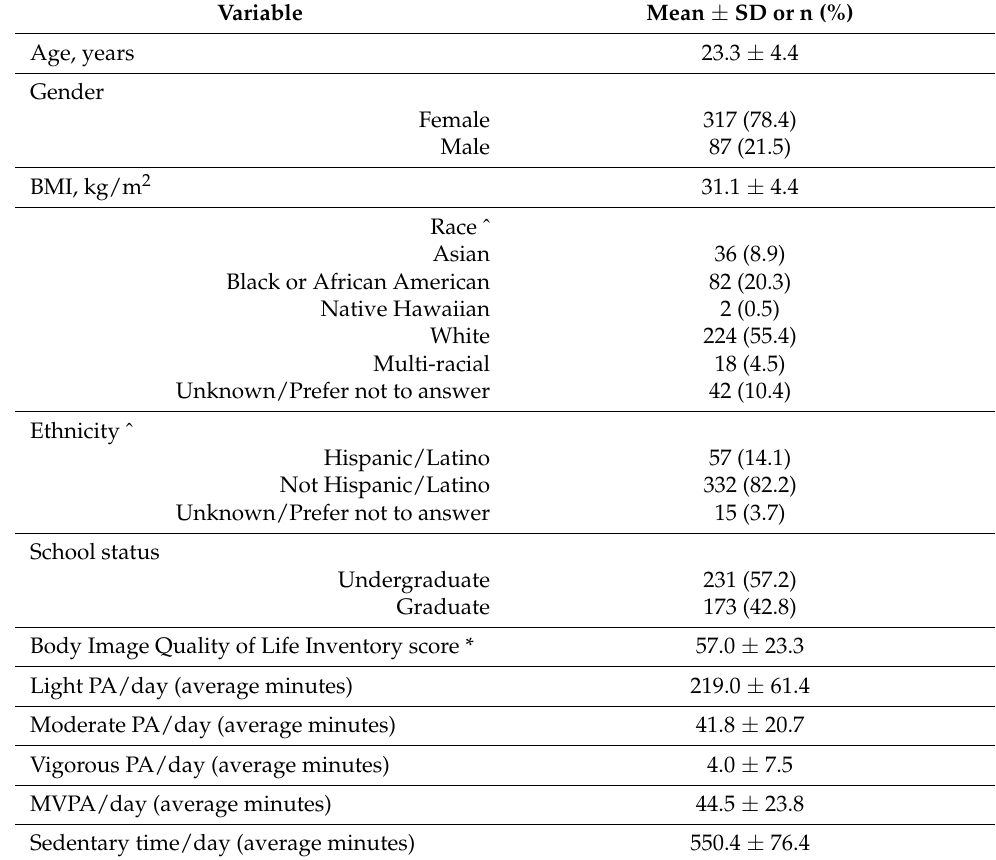
Table 1. Participant demographics (N = 404).